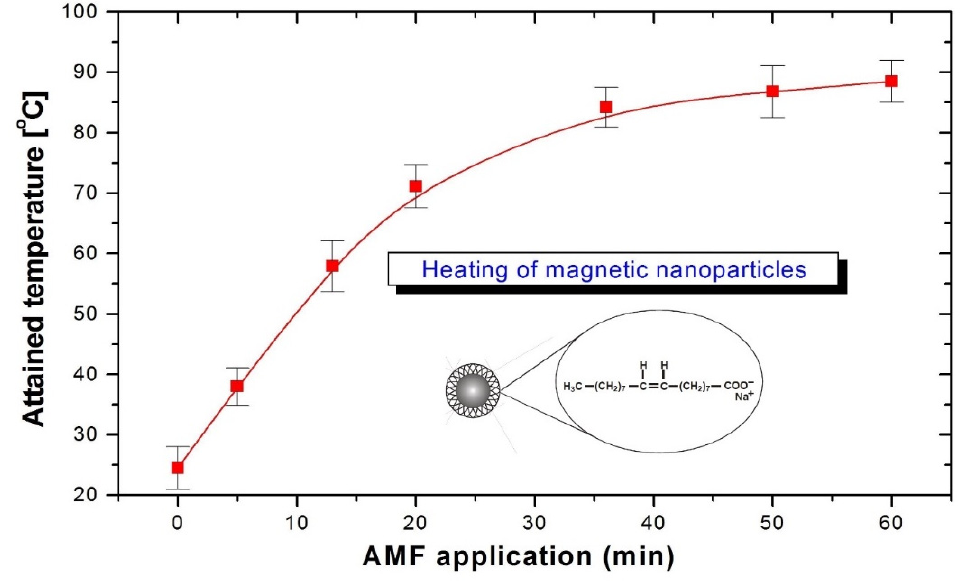
Figure 5. Kinetics of the temperature increase of fluidMAG-OS magnetite nanoparticles in 3.5 MHz AMF. Mean values (red squares) and standard deviations (error bars) from five independent experiments.